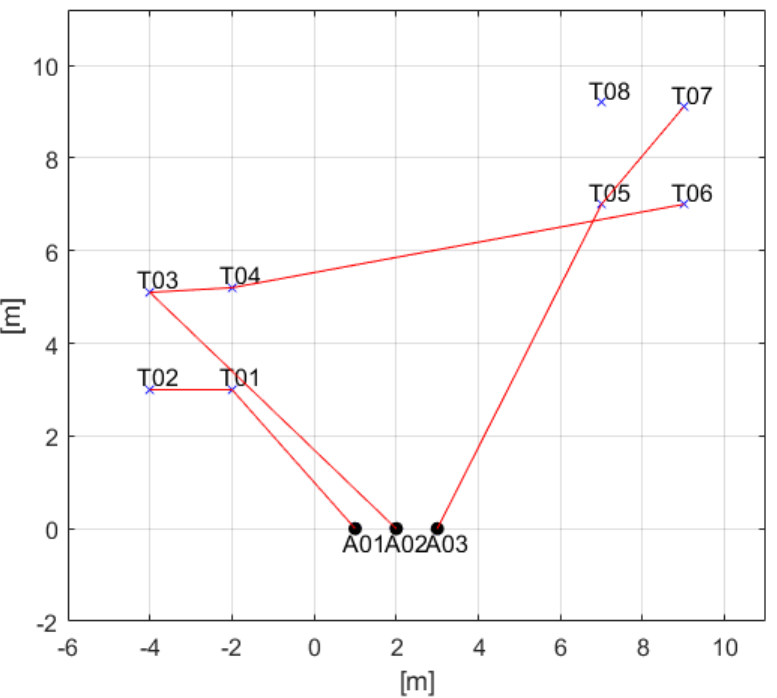
Figure 10. 2 − D result of TACTAR for a complicated case applying an accumulated distance cost scheme.